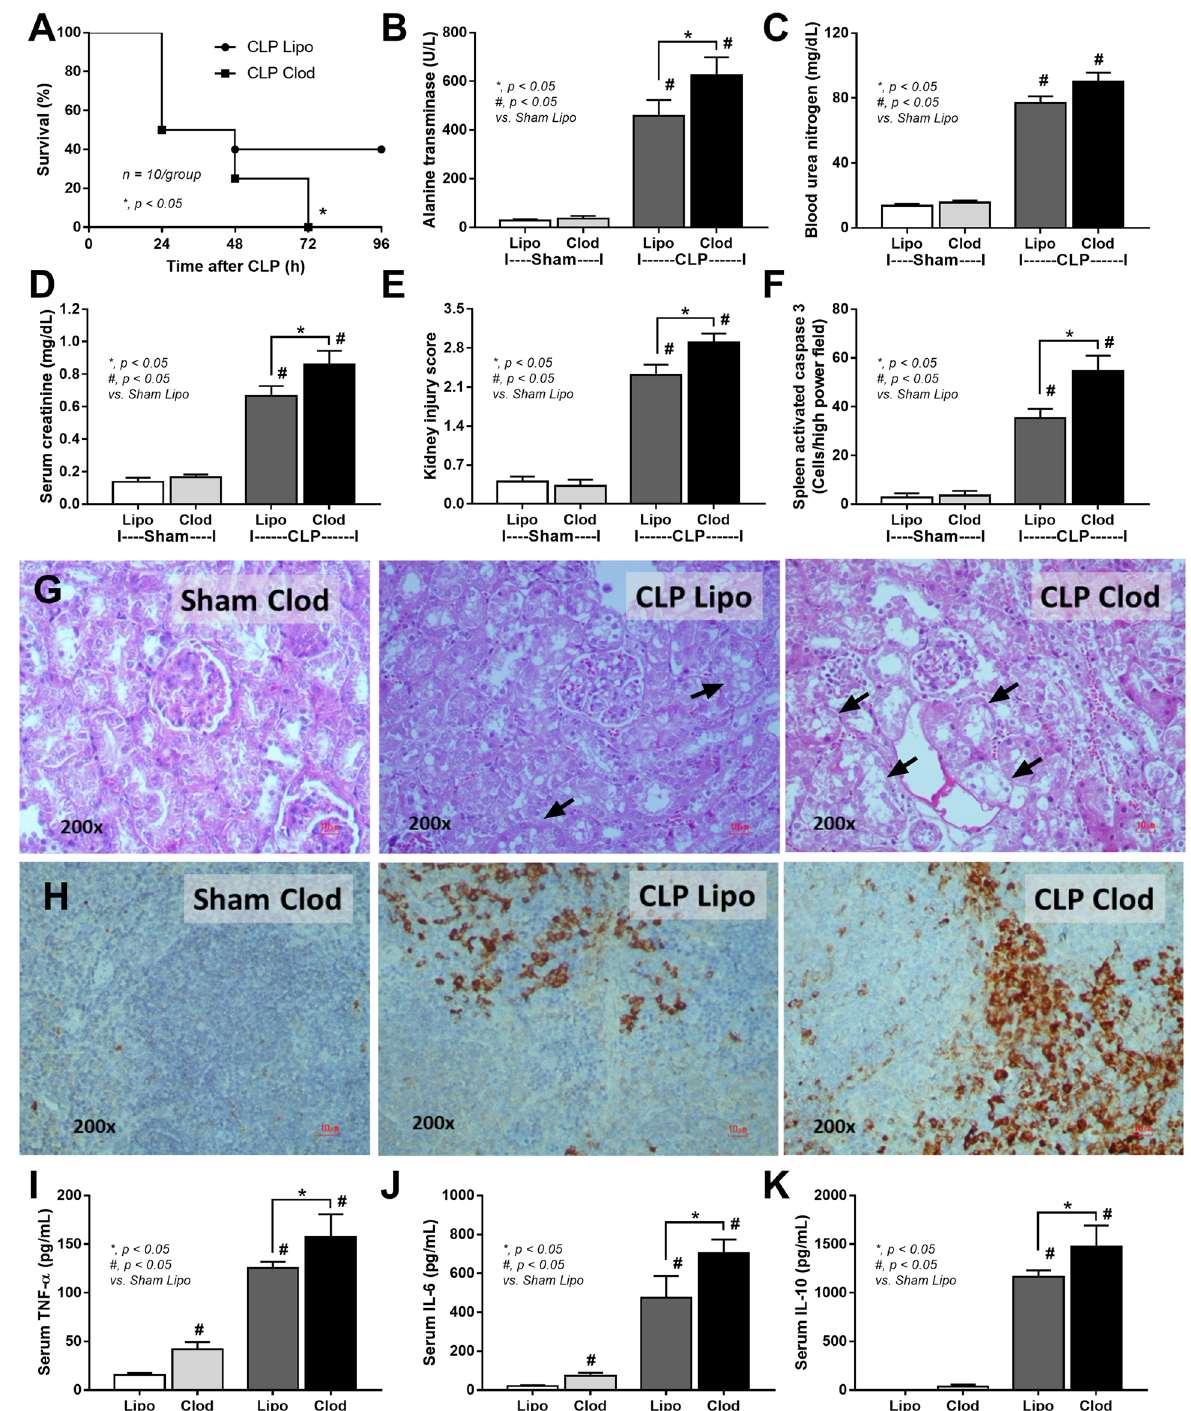
Figure 4. Characteristics of mice with liposomal clodronate (Clod) or liposome control (Lipo) after sham or cecal ligation and puncture (CLP) surgery as indicated by survival analysis ( A ) and several parameters at 24 h post-surgery, including liver injury (serum alanine transaminase) ( B ), kidney damage (blood urea nitrogen, serum creatinine and kidney injury score) ( C – E ), spleen apoptosis (activated caspase 3) with the representative pictures of Hematoxylin and Eosin ( H , E ) stained renal histology and spleen caspase 3 immunohistochemistry ( F – H ) and serum cytokines (TNF-α, IL-6 and IL-10) ( I – K ) are demonstrated (n = 10/group for survival analysis and n = 6–8/group for other parameters). Arrows indicate tubular vacuolization in renal